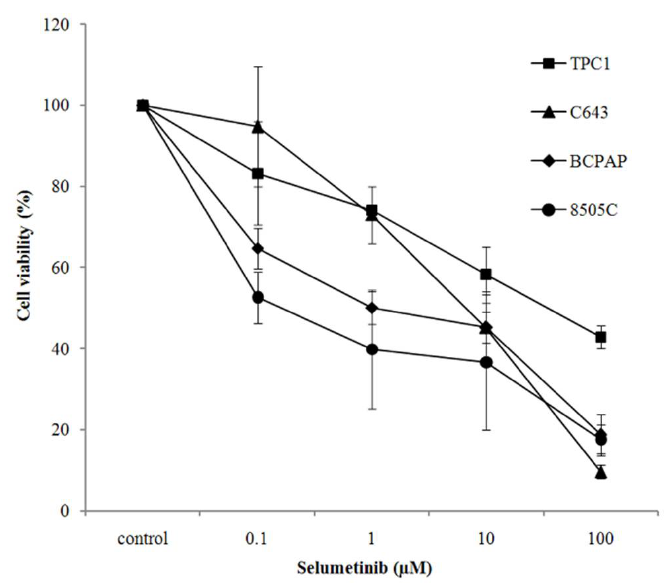
Figure 1. Selumetinib effect on cell viability. Cell viability of TPC1, C643, BCPAP and 8505C cells treated with an increasing concentration of selumetinib for 144 h. Cell viability is expressed relative to the untreated control, which was set to 100%. Data represent mean ± SD of three experiments performed in triplicates.